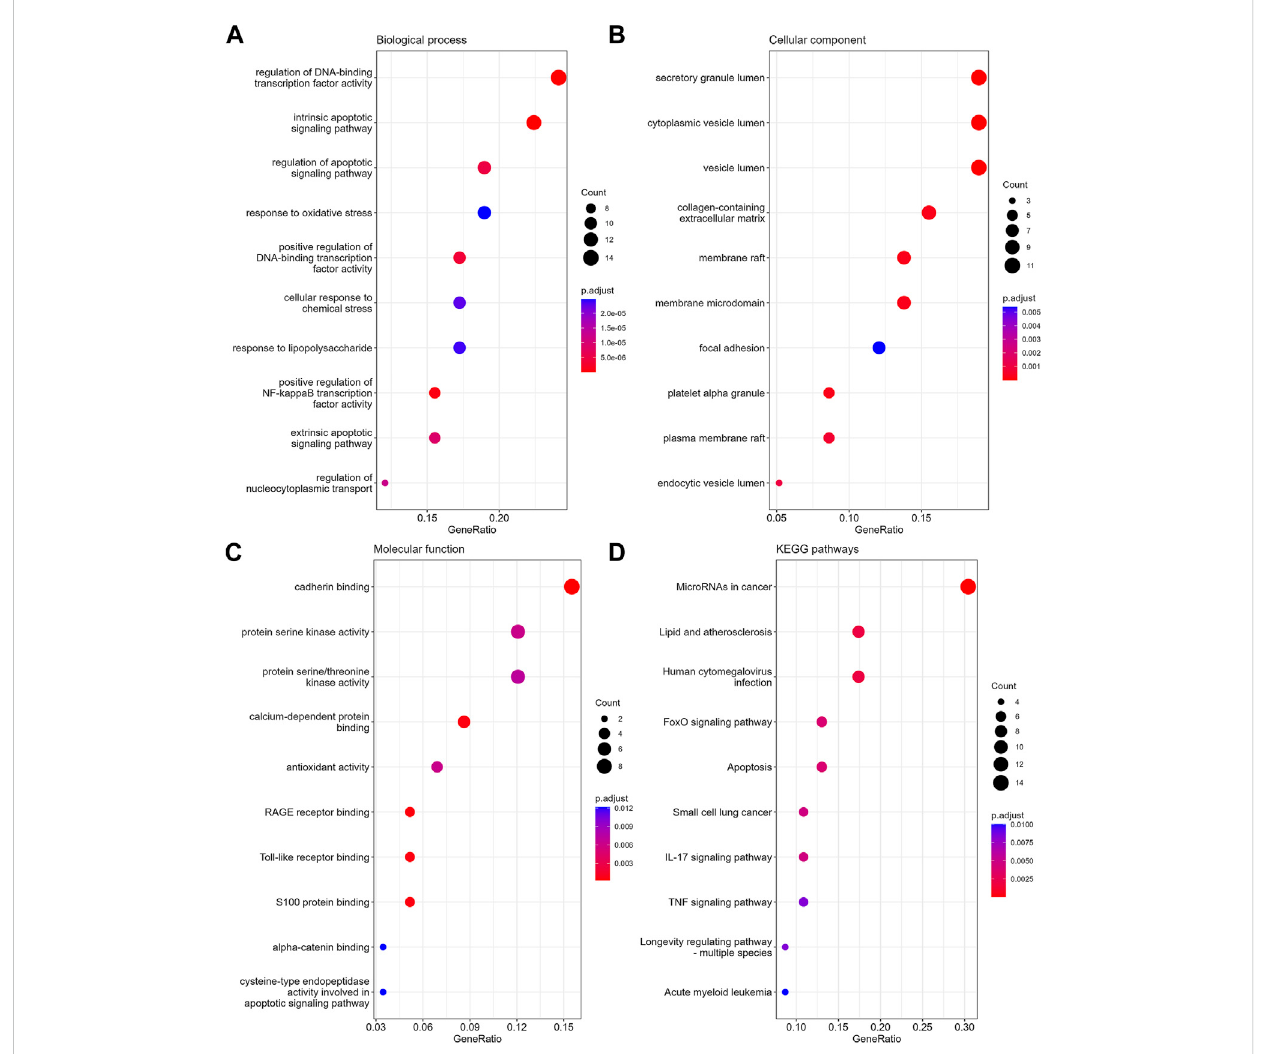
FIGURE 4 The enrichment analysis of anoikis-related DEGs in MPNs. The dot plots display the Top10 terms enriched by anoikis-related DEGs in BPs (A) , CCs (B) , MFs (C) and KEGG pathways (D)